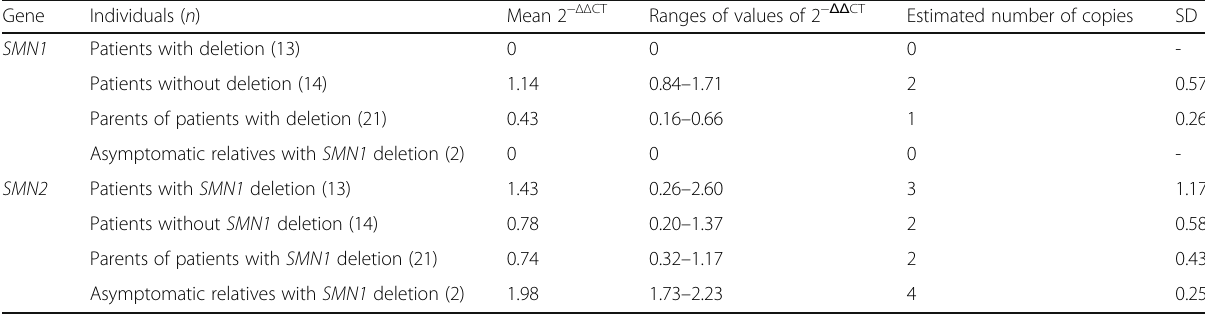
Table 2 Averages of 2 − ΔΔ CT values and range per genotype in patients and carriers Gene Individuals ( n ) Mean 2 −ΔΔ CT Ranges of values of 2 − ΔΔ CT Estimated number of copies SMN1 Patients with deletion (13) 0 0 Patients without deletion (14) Parents of patients with deletion (21) Asymptomatic relatives with SMN1 deletion (2) SMN2 Patients with SMN1 deletion (13) 1.43 Patients without SMN1 deletion (14) 0.78 Parents of patients with SMN1 deletion (21) Asymptomatic relatives with SMN1 deletion (2) SD standard